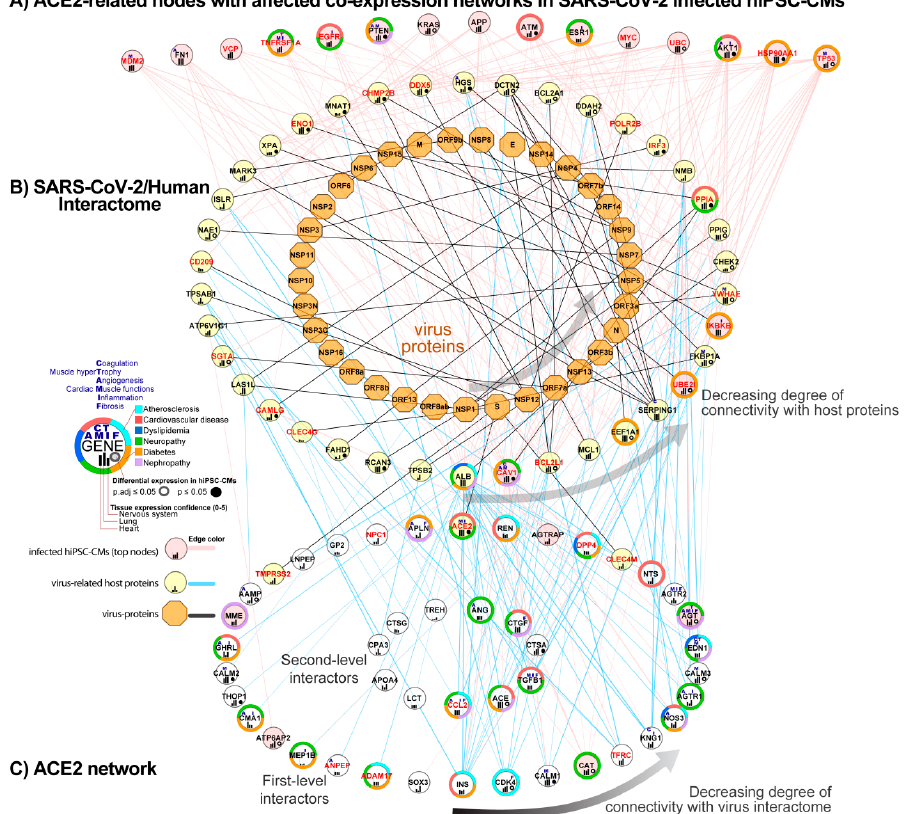
Figure 7. Combined ACE2 network with SARS-CoV-2/Human interactome and co-expression network in infected human-induced pluripotent stem cell-derived cardiomyocytes (hiPSC-CMs). ( A ) Hub nodes identified in the co-expression network analysis of infected hiPSC-CMs using the NERI algorithm, showing the highest connectivity with SARS-CoV-2/Human interactome (top 15 genes). ( B ) SARS-CoV-2/Human interactome as shown in previously published work [39]. ( C ) ACE2 network components that interact with SARS-CoV-2/Human interactome proteins. Nodes from network A which have the highest connectivity are sorted from right to left. Nodes from the networks B and C are circularly sorted by the number of connections with virus interactome. Virus proteins are shown as orange octagons, while virus-infection related human proteins have red labels.